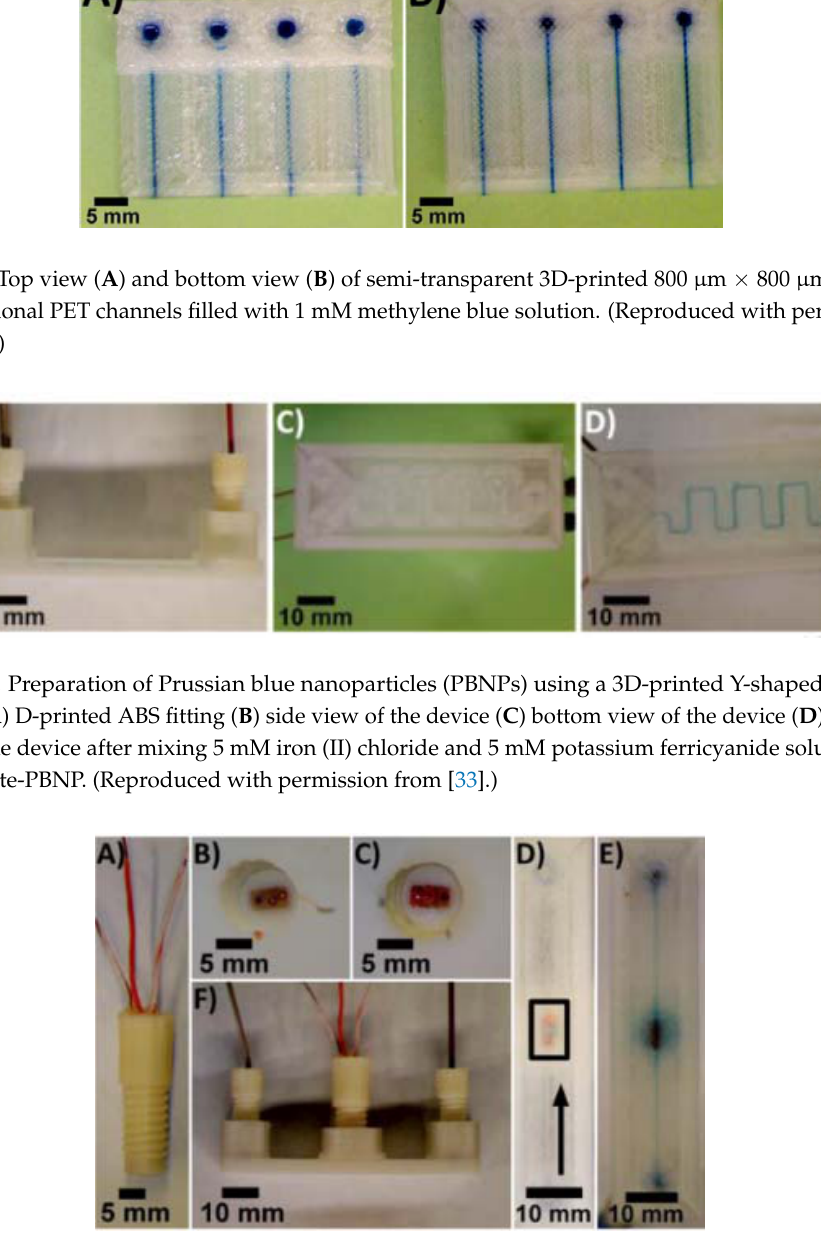
Figure 11. Electrodes embedded in the fluidic channel. ( A ) Threaded ABS fitting with integrated electrodes; ( B , C ) Bottom view of the fittings equipped with different reference, working, and counter electrodes; ( D ) Bottom view of a 3D ‐ printed PET device with reference, working, and counter electrodes (bottom to top) incorporated in the fluidic channel. The arrow indicates direction of flow. ( E , F ) Bottom and side views, respectively, of the device filled with methylene blue in PBS. (Reproduced with permission from [33].)